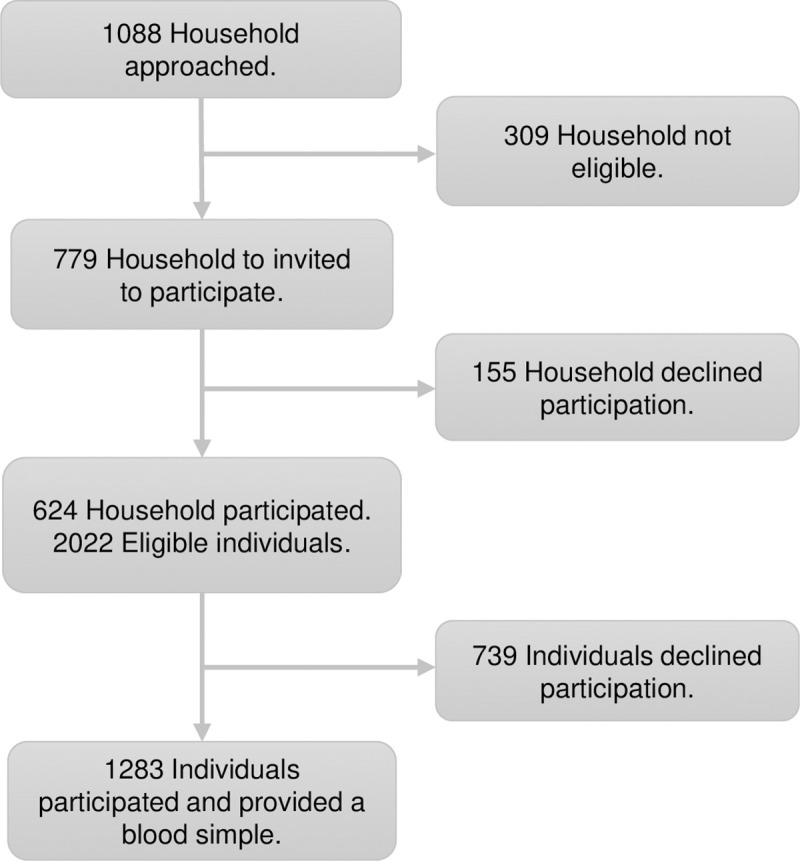
Flowchart of the inclusion of households and participants.